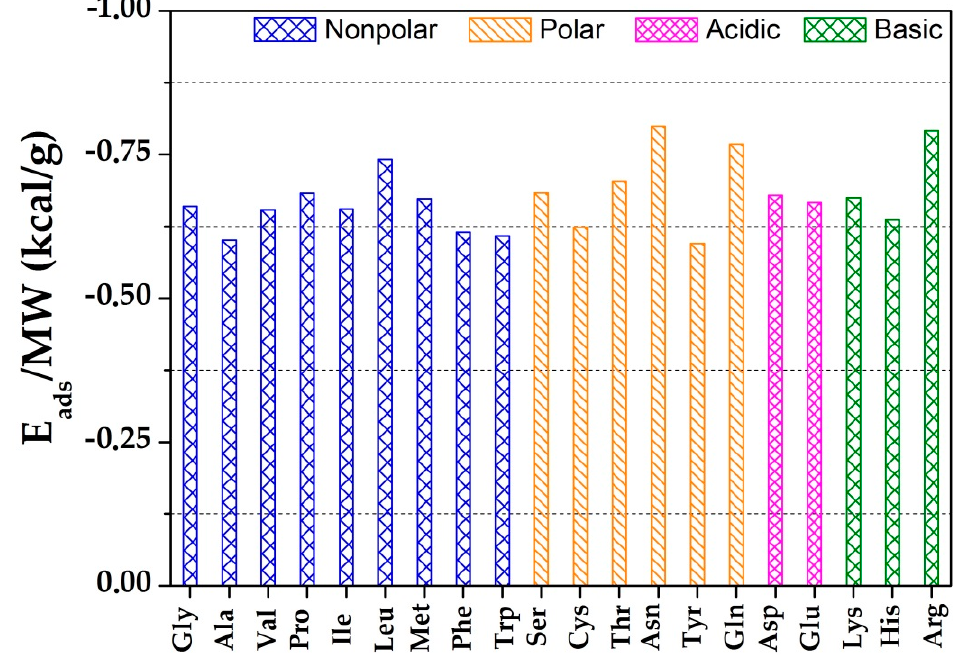
Figure 6. The specific adsorption energy (E ads /MW) obtained from Monte Carlo simulations of L-amino acids on an Fe (100) surface in gas phase. L-amino acids on an Fe (100) surface in gas